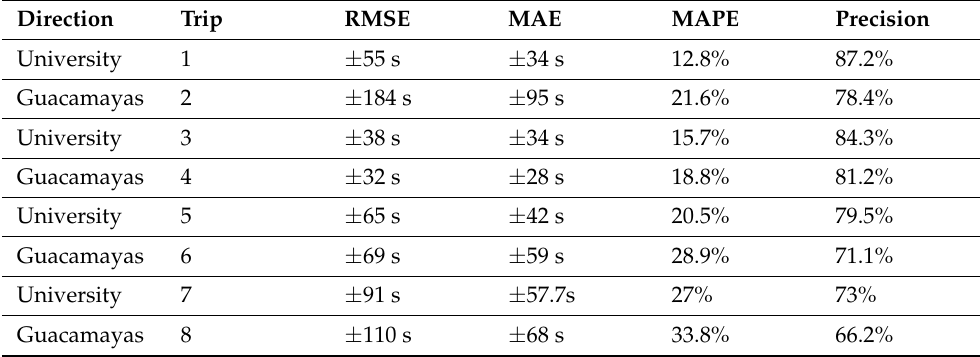
Table 9. Results obtained for Journeys: University–Guacamayas,